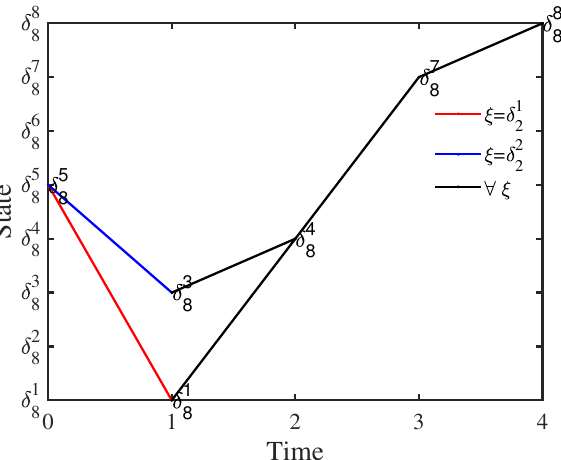
Figure 3. Evolutionary trajectories of initial state δ 5